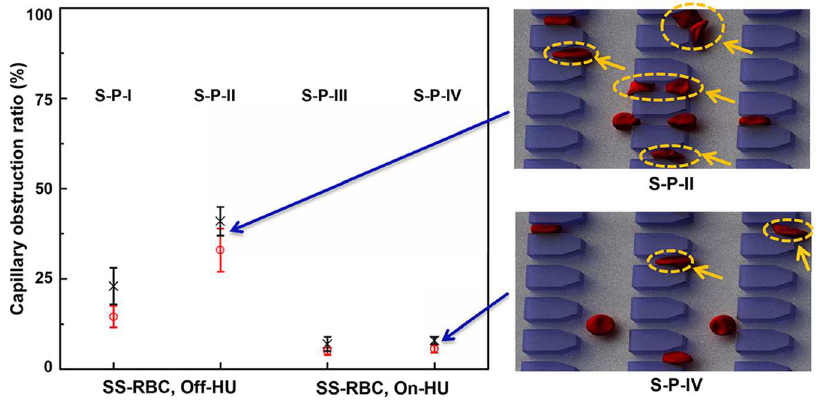
Fig 6. Microfluidic studies of single-cell capillary obstruction for blood samples of on-HU groups and off-HU groups. The cross symbols show the measuredexperimental data and the circles show the